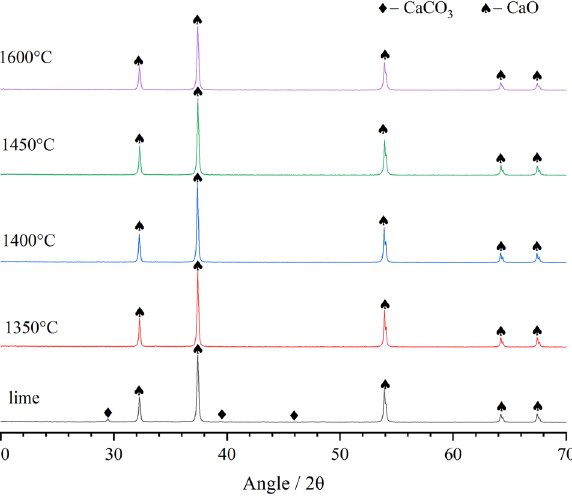
Figure 4: Mineral composition of the samples collected at di ff erent